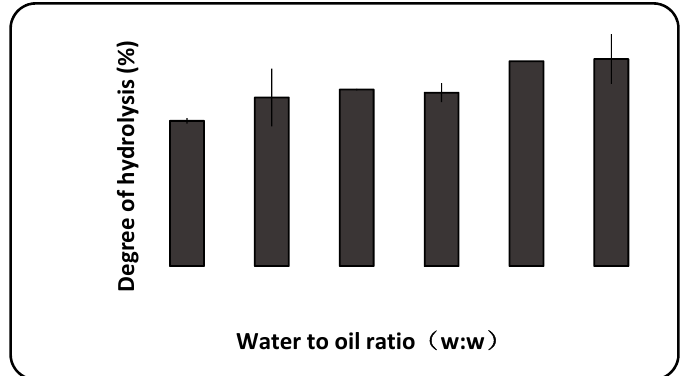
Figure 2. The effect of the water to oil ratio on the hydrolysis of Schizochytrium sp. oil. Conditions: Temperature 200 °C, pressure 2.0 Mpa, 5 hours, 150 rpm.